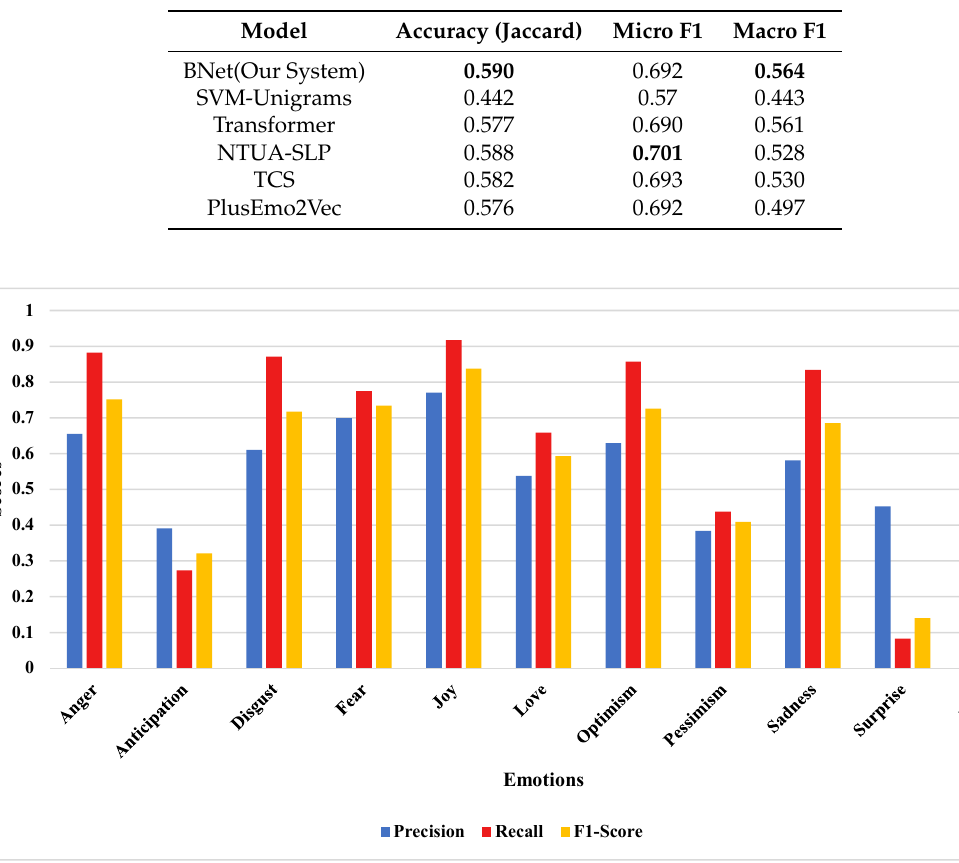
Table 2. Results of our system and state-of-the-art systems. The best values are in bold.